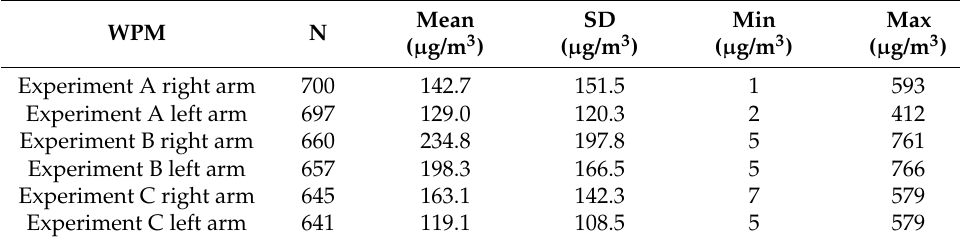
Figure 5. Indoor positioning results. Each dot indicates the position coordinates computed by the Wi-Fi RTT. The location information was calculated as the median value of the X- and Y -axis coordinates every second. The range enclosed by the dotted line and the Y -axis is the walking range. ( A–C ), indicate Experiments A, B, and C, respectively. The results of the WPM measurements are shown in Table 4 and Figure 6. Table 4. Descriptive statistics of dust measurement results. Table 4. Descriptive statistics of dust measurement results.